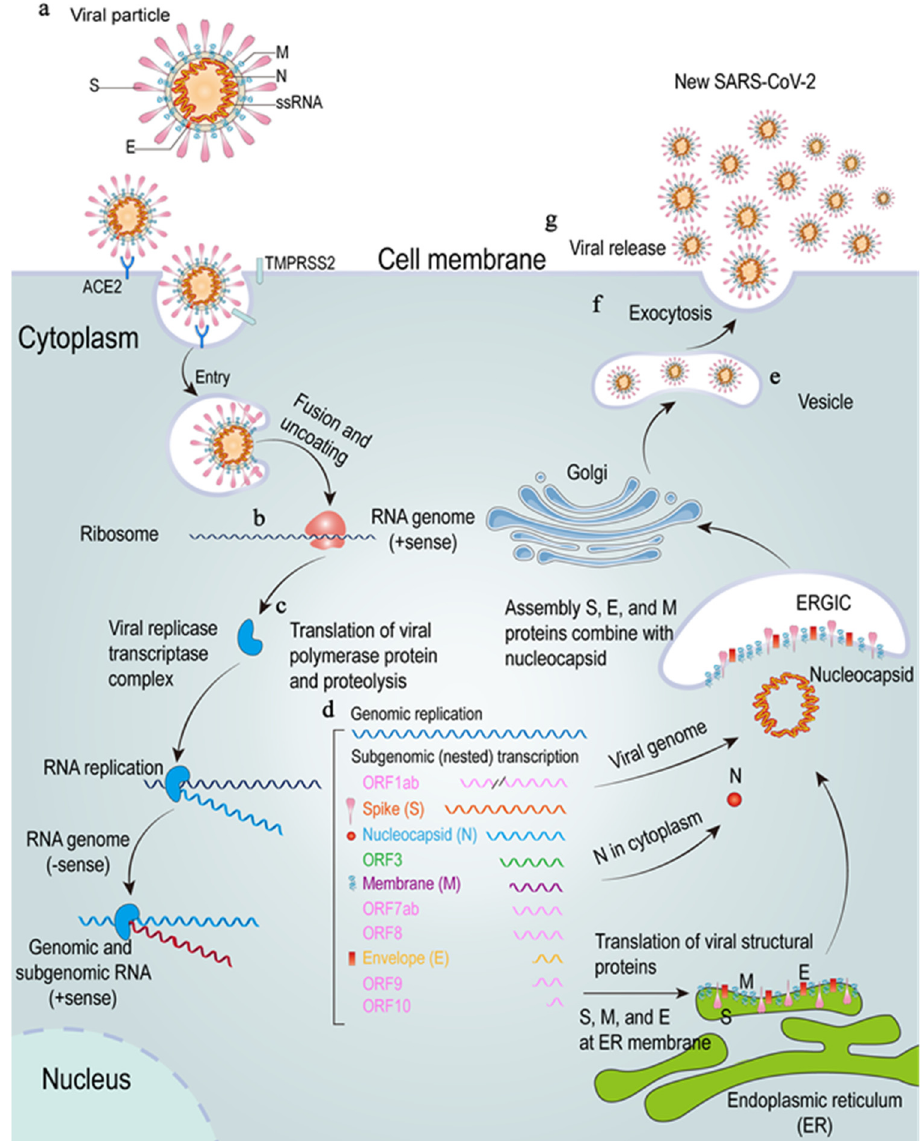
Figure 1. The SARS-CoV-2 lifecycle. ( a – d ), SARS-CoV-2 enters through membrane fusion and uncoating. The SARS-CoV-2 S protein combines with the ACE2 and TMPRSS2 to release RNA ( b ), and the genome RNA is translated into viral proteins ( c ). ( d – g ), these proteins will produce a viral replicase transcriptase complex to produce additional RNA ( d ). Subgenomic RNA transcription leads to the production of structural proteins and accessory proteins, which are translocated to endoplasmic reticulum (ER) membranes and go through the ER-Golgi intermediate compartment (ERGIC) to assemble a virus to produce new SARS-CoV-2 ( e ) and then will be released by exocytosis ( f , g ). ssRNA: single-stranded RNA; ACE2: angiotensin-converting enzyme 2; TMPRSS2: